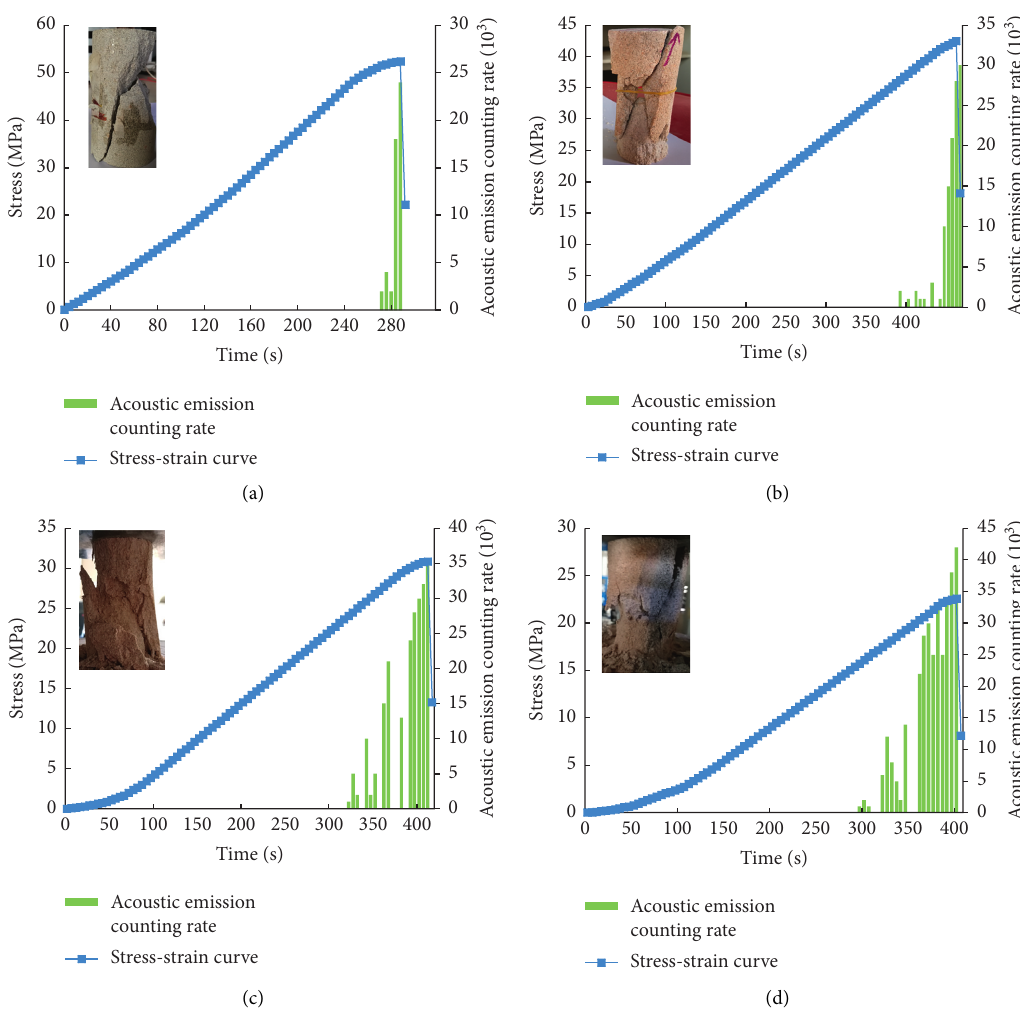
Figure 4: Acoustic emission response and damage. (a) C2. (b) N1. (c) W2. (d)